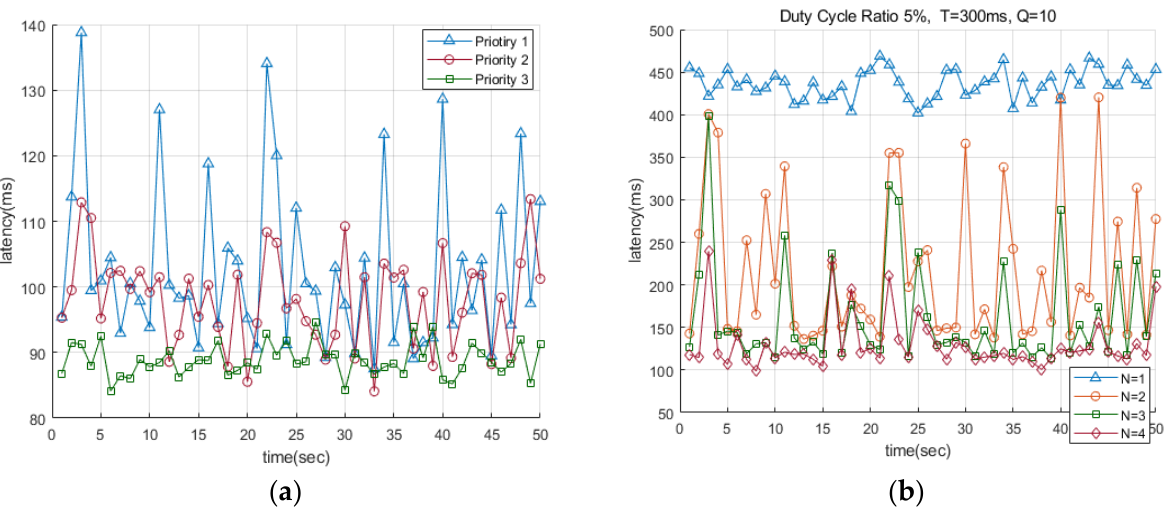
Figure 7. Comparison of latency Pre-emption MAC: ( a ) Delay time of various pre-emption MAC; ( b ) Delay time according to the number of receiving nodes.